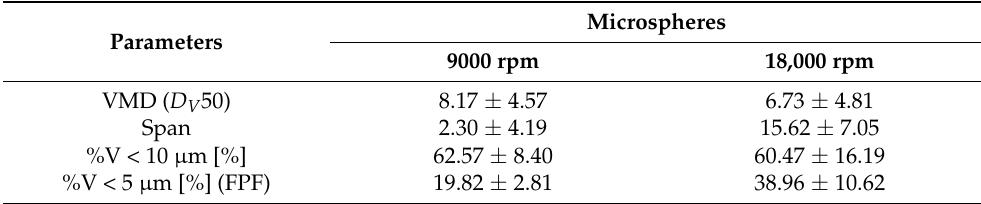
Table 6. Aerosol properties of selected microspheres a obtained from polyDBB_PEG_600_20.